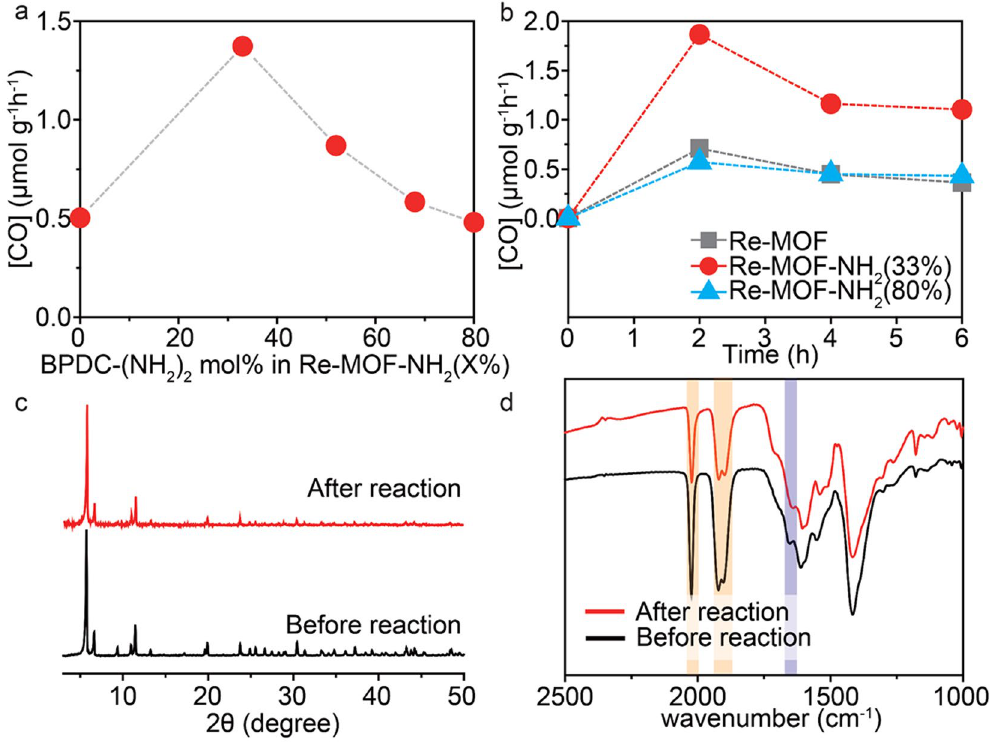
Figure 3. Photocatalytic activity and stability of Re-MOF-NH 2 (X%). ( a ) Photocatalytic CO 2 -to-CO conversion activity under visible light (400–700 nm). ( b ) Photocatalytic CO 2 conversion rate under visible light. ( c ) PXRD of Re-MOF-NH 2 (33%) before and after the reaction. ( d ) IR spectra of Re-MOF-NH 2 before and after the